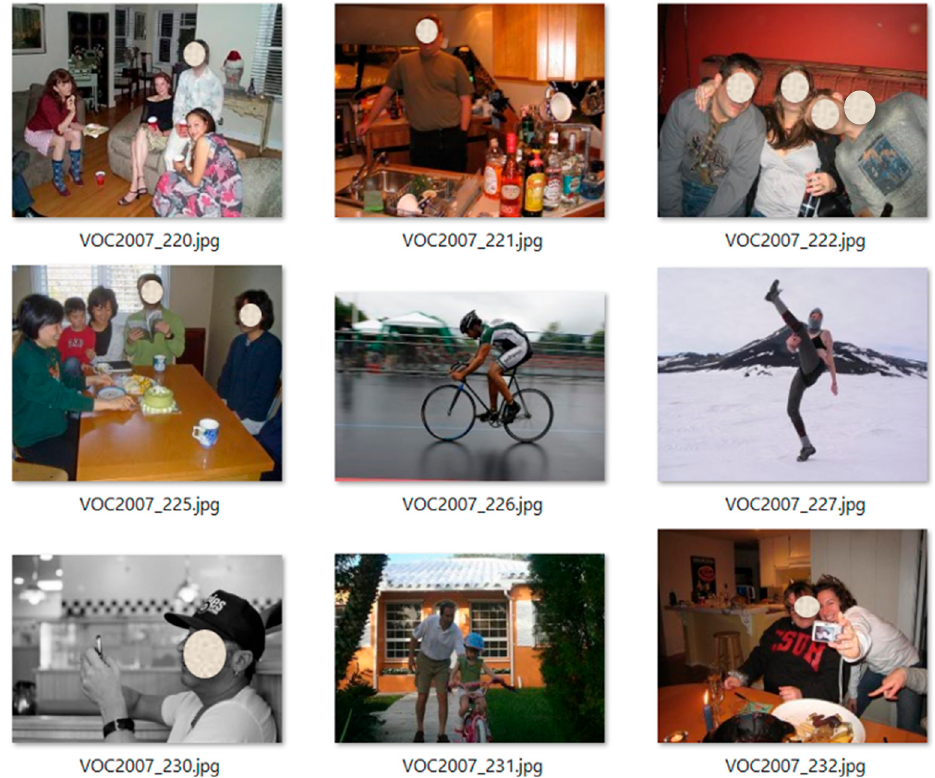
Figure 3. Oxford Hand Dataset sample images. Source: The human faces in the figures are all from public datasets (Oxford Hand Dataset).